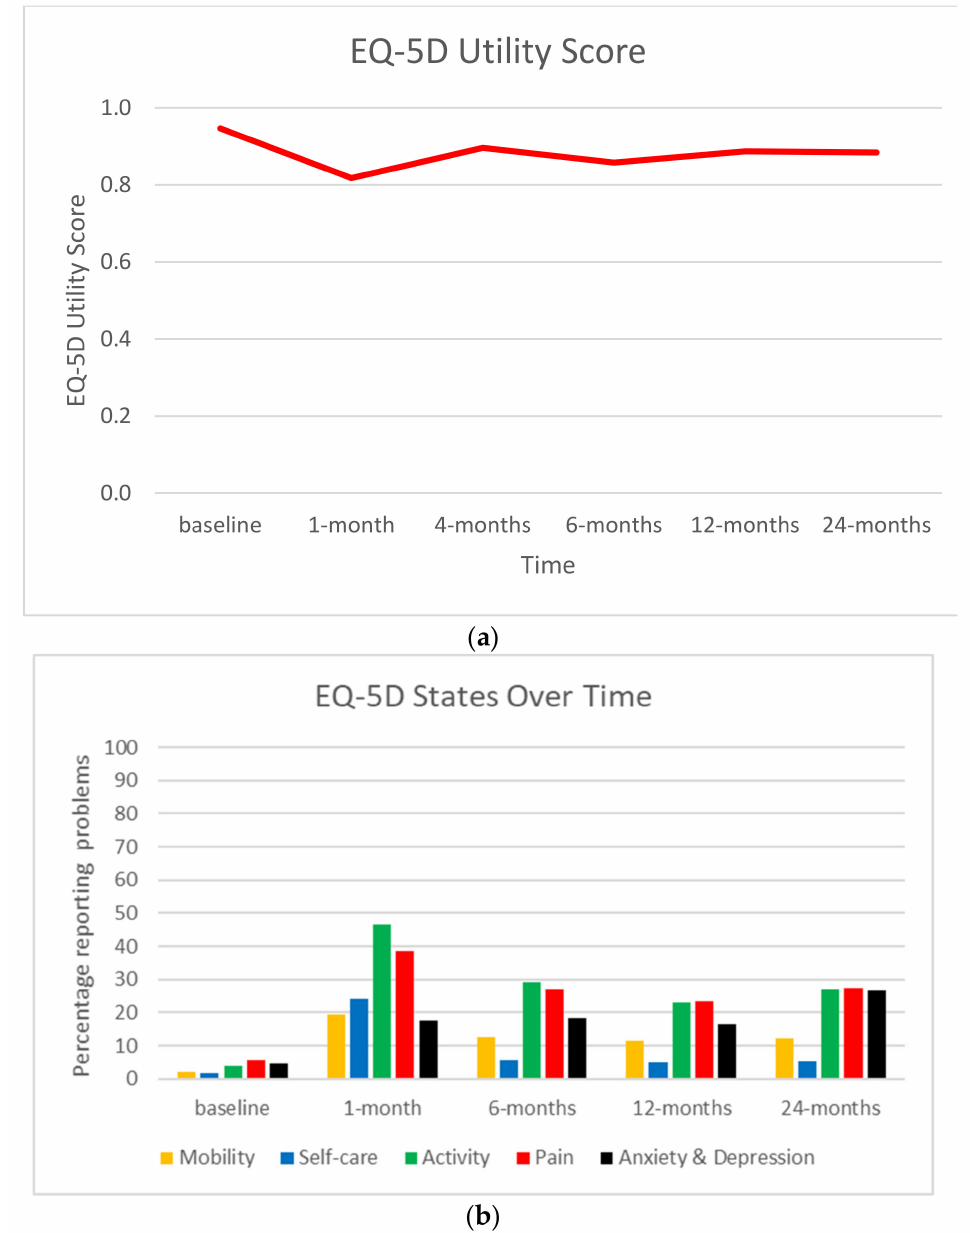
Figure 1. EQ-5D over time. ( a ) EQ-5D utility score. ( b ) Percentage of participants reporting problems (some or